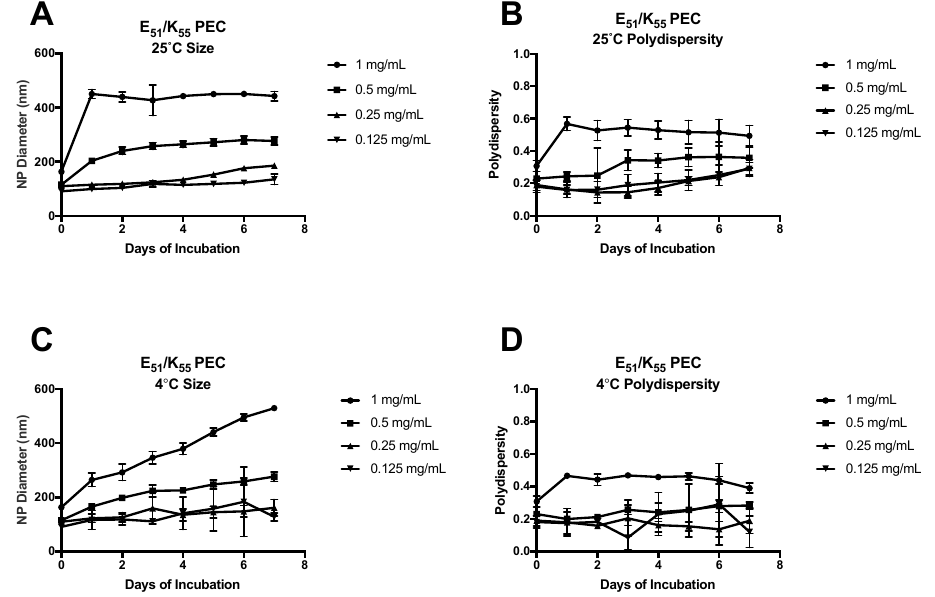
Figure 2. Stability of E 51 /K 55 PEC formed from 1:1 charge ratio at 25 °C and 4 °C. Panels ( A , B ) show the size and polydispersity, respectively, of PEC formed from E 51 and K 55 at a 1:1 charge ratio at 25 °C over 7 days. At 1 mg/mL and 0.5 mg/mL there was an increase in size and polydispersity after 24–72 h of incubation, followed by plateau. The 0.25 and 0.125 mg/mL formulations showed little change in diameter over 7 days and a slight increase in polydispersity; Panels ( C , D ) show the size and polydispersity, respectively, of PEC formed from E 51 and K 55 at a 1:1 charge ratio at 4 °C over 7 days. No plateau was reached in diameter for the 1 mg/mL or 0.5 mg/mL formulations, while the 0.25 and 0.125 mg/mL formulations showed little change. The polydispersity showed an increase after 24 h in the 1 mg/mL formulation, followed by plateau, while the lower concentrations remained nearly constant with minor fluctuations. Data were obtained by DLS, and are displayed as averages over 3–4 wells ± standard deviation.